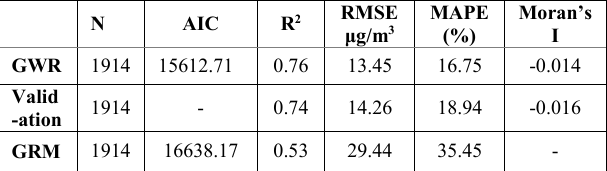
Table. 1. Results of the GWR model, validation for the GWR, and Global Regression Model